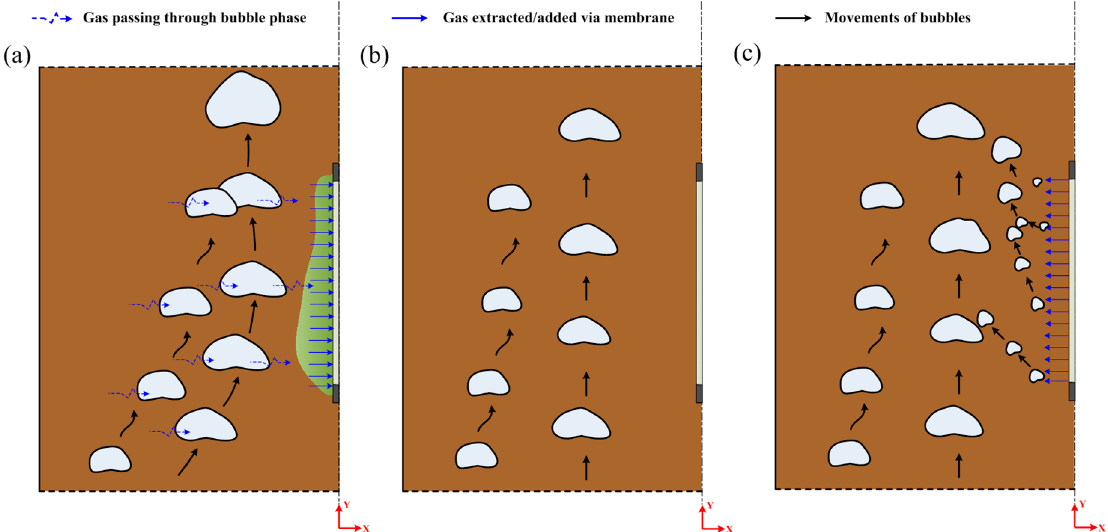
Figure 16. Illustration of the gas movement in the bed during ( a ) gas extraction; ( b ) normal operation; ( c ) gas addition.